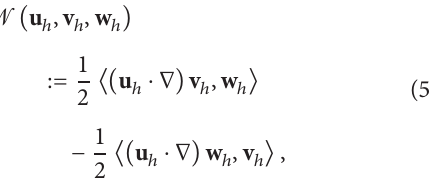
Algorithm 1 (the fully discrete stabilized